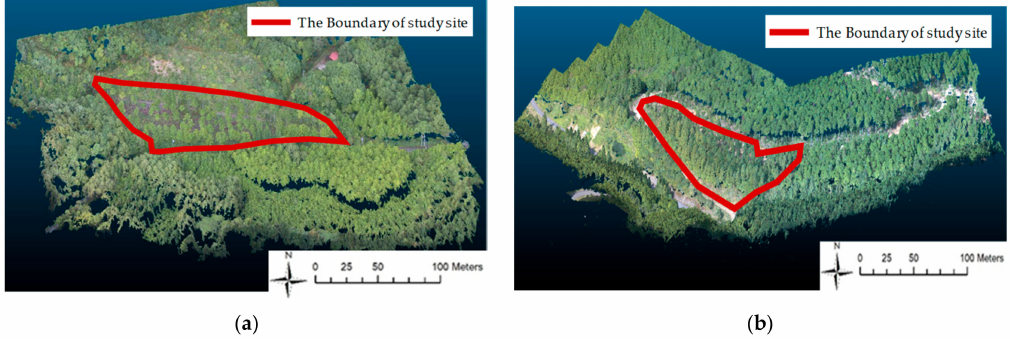
Figure 4. Point cloud data ( a : Site 1, b : Site 2) Red lines show the boundary of study sites. Grey lines from east to west in Site 1 and from north west to south in Site 2 are roads and white paths in north east area in Site 1 and in east area in Site 2 are forest